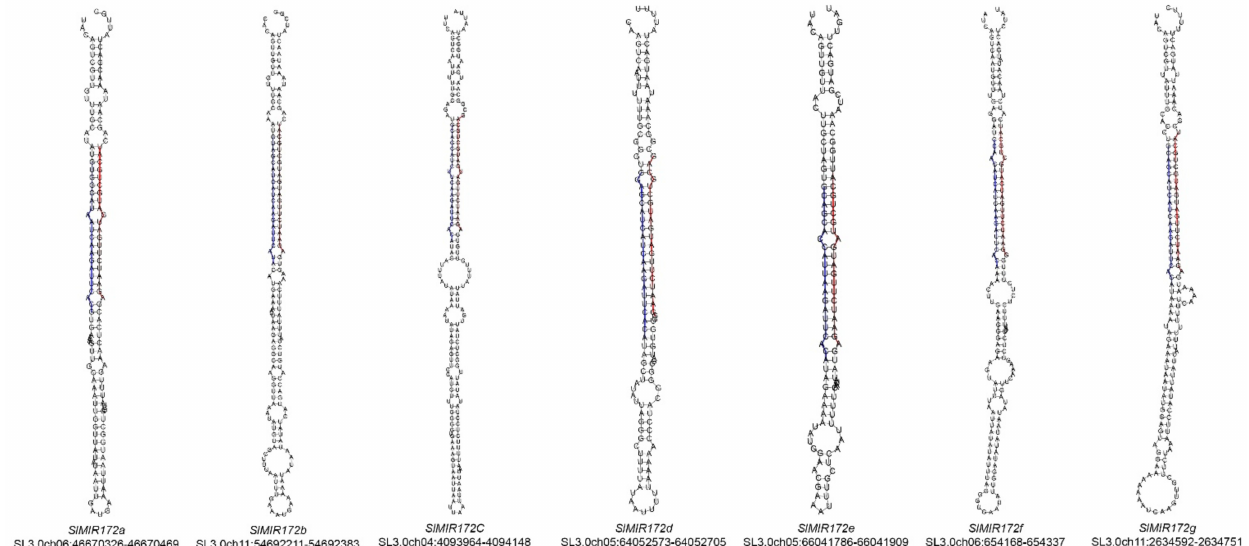
Figure A1. Hairpin secondary structures of sly-miR172 precursors as predicted by RNAfold (http://rna.tbi.univie.ac.at/ cgi-bin/RNAWebSuite/RNAfold.cgi, accessed on 1 January 2021). The position of each precursor in the tomato genome (SL3.0) is indicated. Mature sly-miR172 and respective sly-miR172* sequences are marked by red and blue,